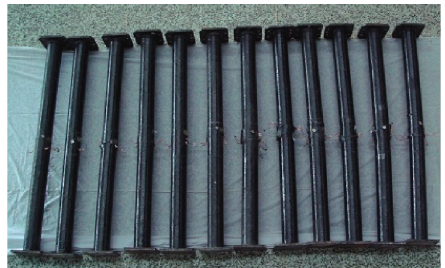
Figure 7: The C-CF-CFRP-ST specimens after loading.